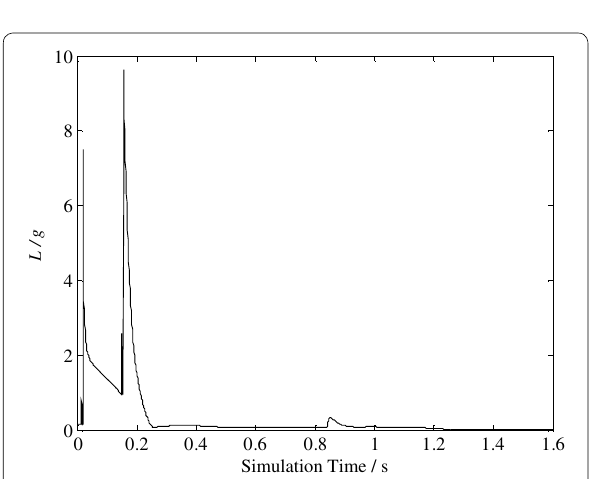
less influence on the stability distance. So v x is neglected while establishing the response surface model of stability distance.